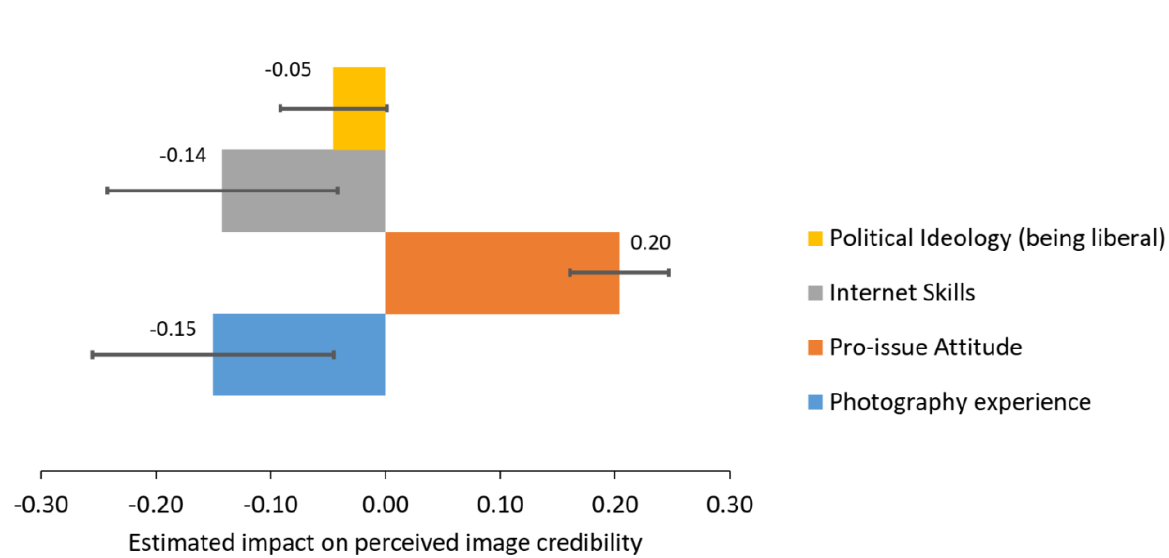
Figure 2. Factors associated with participants’ perceived image credibility rating. Numbers represent unstandardized regression coefficients. All factors were significant at .05 except political ideology, which was marginally significant (p = .06). Error bars represent 95% confidence intervals for the